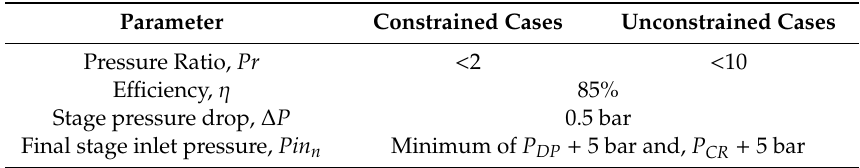
Table 1. Summary of compressor modelling